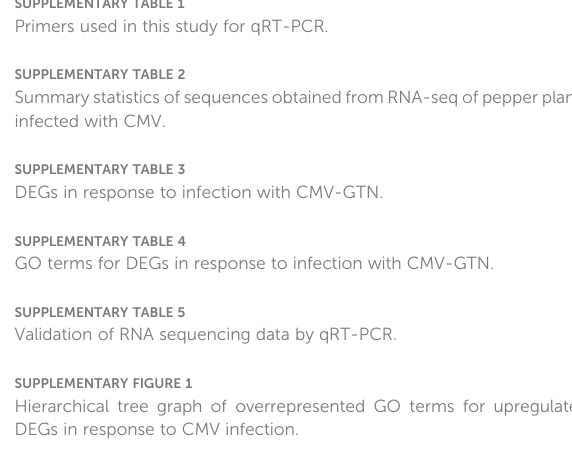
SUPPLEMENTARY FIGURE 1 Hierarchical tree graph of overrepresented GO terms for upregulated DEGs in response to CMV